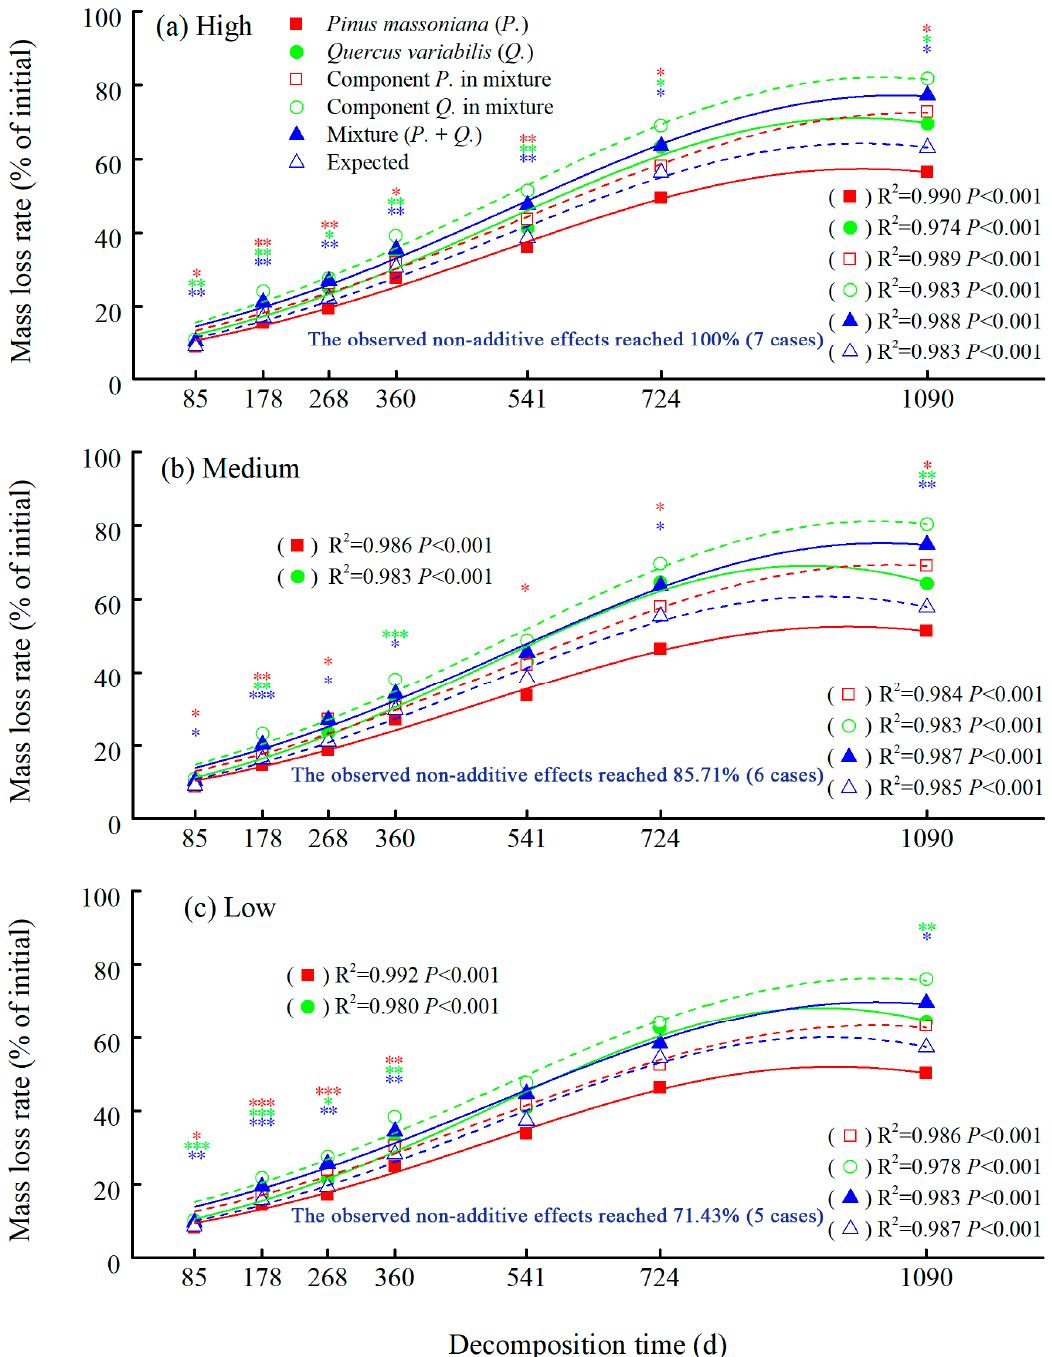
Figure 1. Dynamics of leaf litter decomposition in terms of mass loss rate in different soil nutrient substrates. The insets show results of independent samples t -test for pairwise combinations of the corresponding cases (they are between single P. and component P. in the mixture, between single Q. and component Q. in the mixture, as well as between the observed (mixture) and expected value, shown in the corresponding color) in the same sampling time. Statistical significance levels are ***, p < 0.001; **, p < 0.01; and *, p < 0.05. Inset percentages indicate the proportion of corresponding observed signi fi cant interactions (non-additive e ff ect) in a total of seven cases for one soil condition.